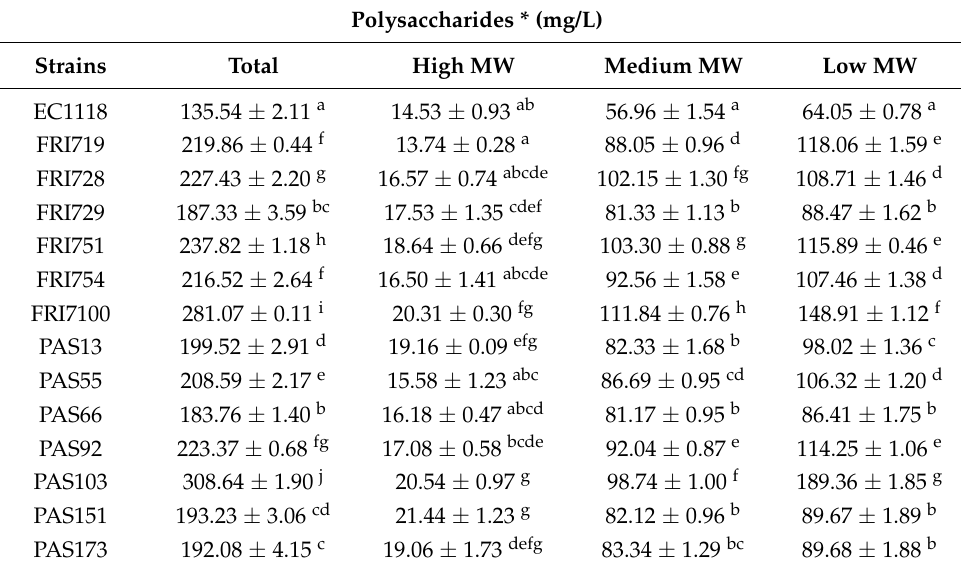
Table 4. Total polysaccharides and their fractions by SEC-HPLC in Sauvignon blanc wine.